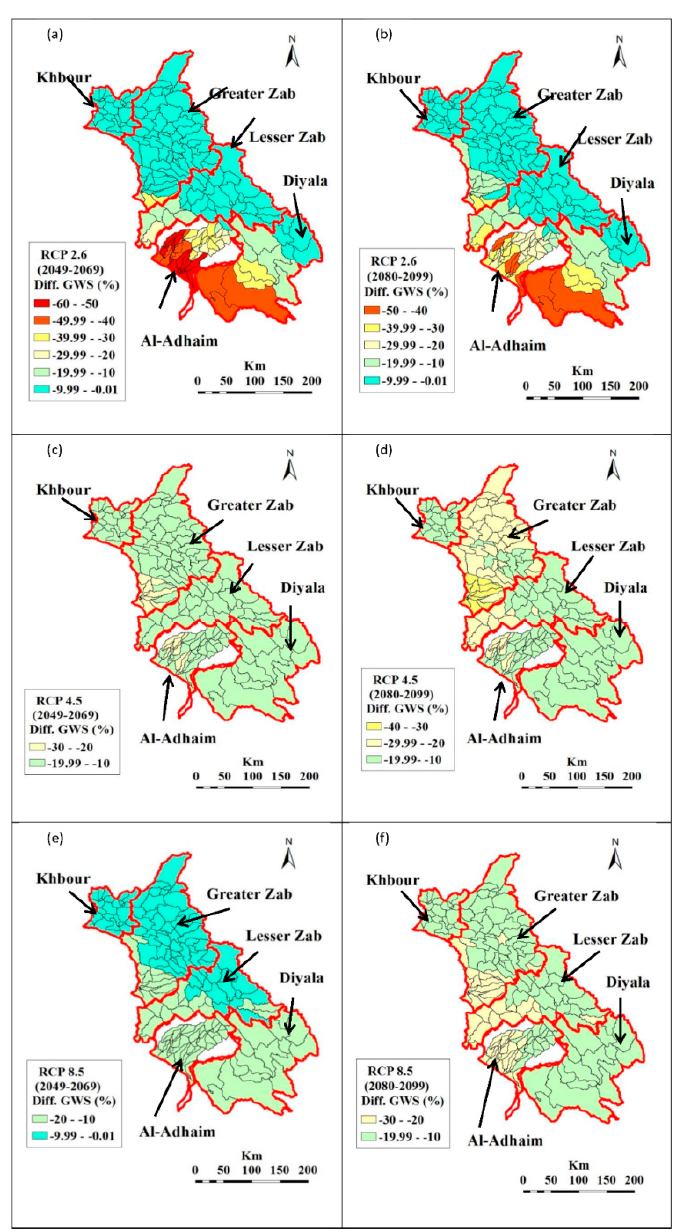
Figure 9. The impacts of climate change on the green water of the five basins ( a ) Anomaly based on scenario RCP2.6 for the period 2049–2069, ( b ) Anomaly based on RCP2.6 for 2080–2099, ( c ) Anomaly based on RCP4.5 for 2049–2069, ( d ) Anomaly based on RCP4.5 for 2080–2099, ( e ) Anomaly based on RCP8.5 for 2049–2069, and ( f ) Anomaly based on RCP8.5 for